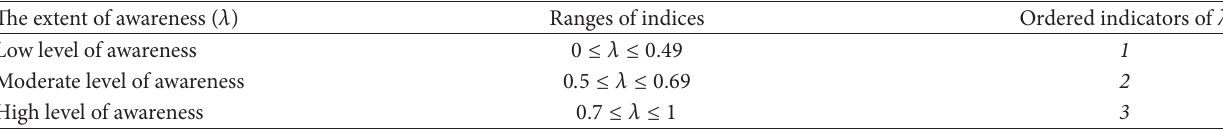
Table 1: Extent of awareness of health implications of agrochemical